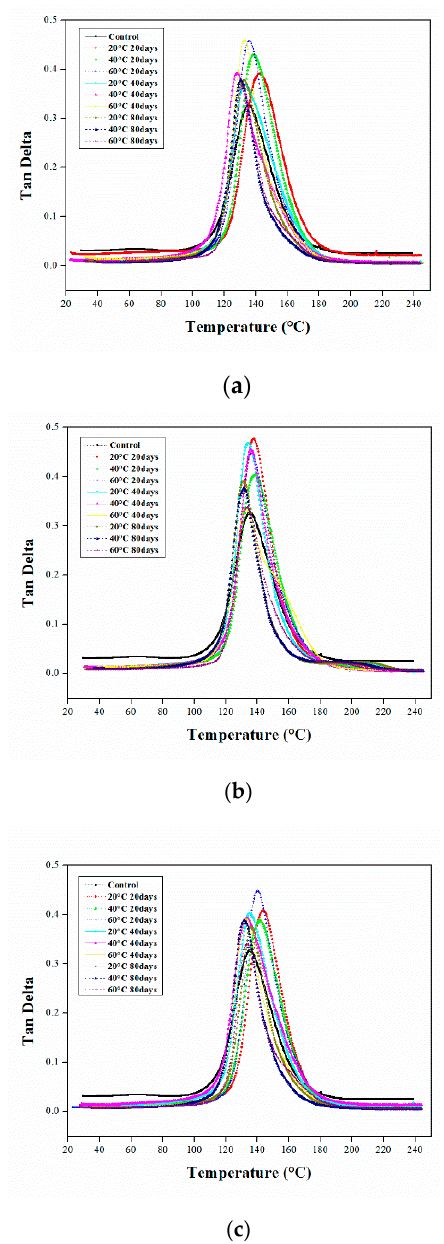
Figure 4. DMA tan delta curves of CFRP composites in different immersion temperatures ( ▫ ; control, ◦ ; at 20 °C, Δ ; at 40 °C, +; at 60 °C) for (..; 20 days, -; 40 days, ---;80 days) in various solutions ( a ) Water, ( b ) HCl, and ( c ) NaOH solution.